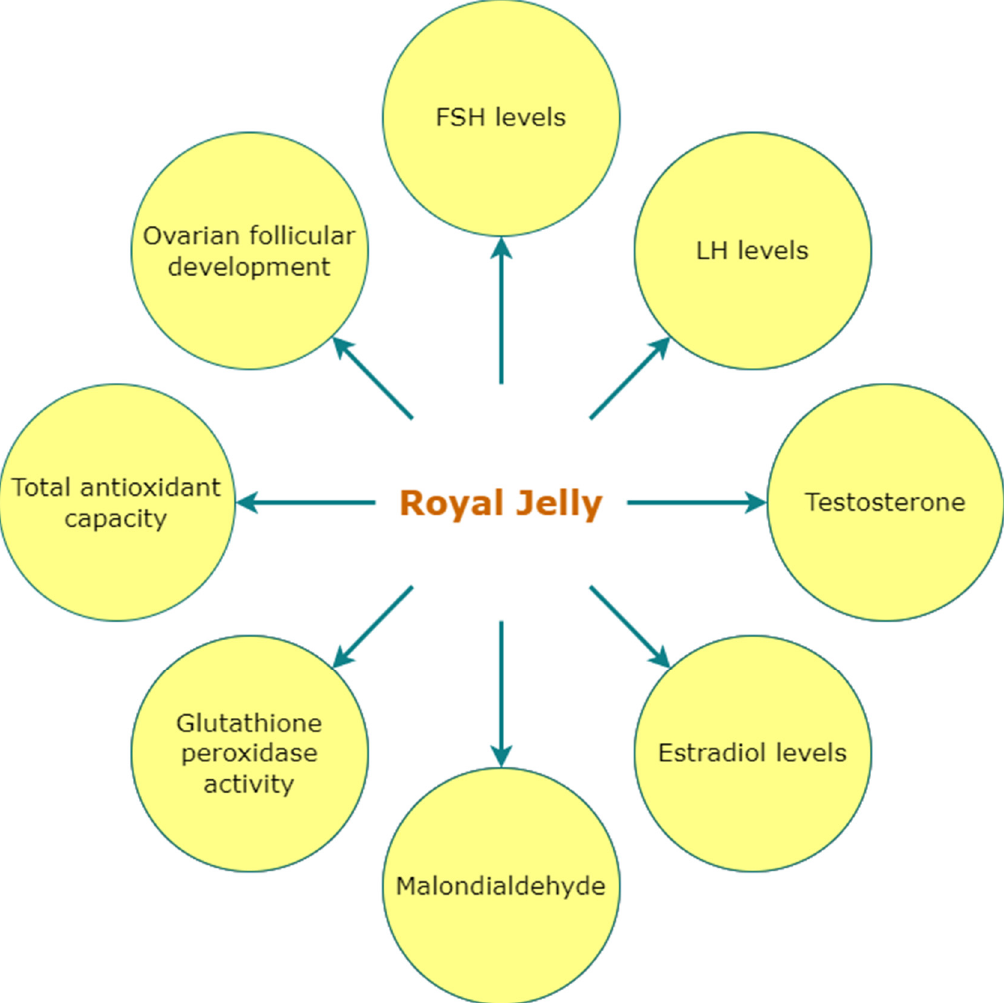
Figure 5. Royal jelly affected parameters related to PCOS .